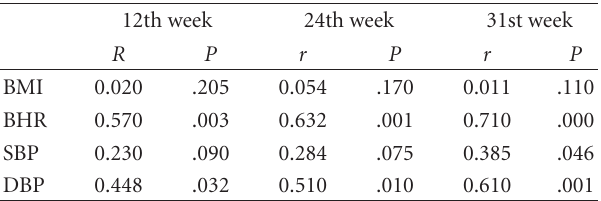
Table 6: Correlation of LF-HF ratio with body mass index (BMI), basal heart rate (HR), systolic blood pressure (SBP), and diastolic blood pressure (DBP) of subjects of late-onset PIH group at di ff erent weeks of gestation.